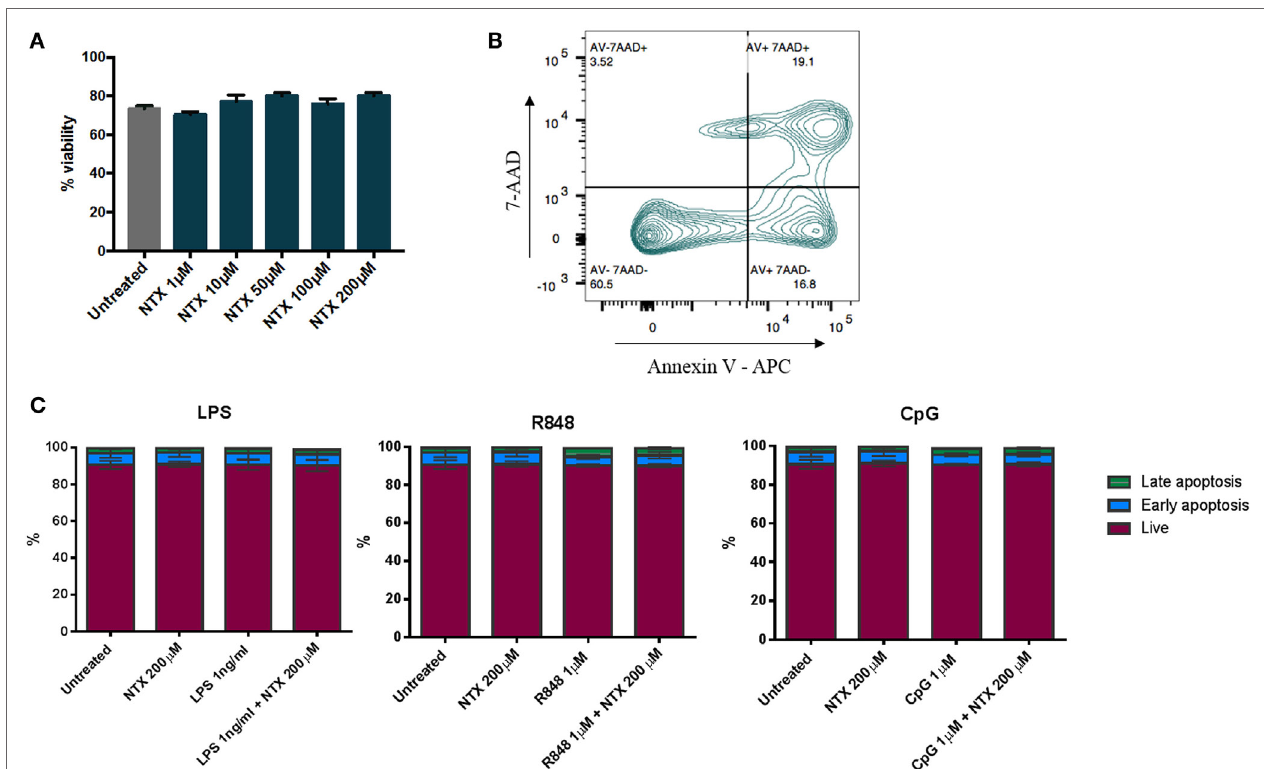
FigUre 4 | Toll-like receptor ligand (TLR-L) and naltrexone does not affect the viability of peripheral blood mononuclear cells (PBMC). (a) 1 × 10 6 PBMC were incubated with 1–200µM naltrexone for 24 h before percentage viability was assessed using trypan blue exclusion. (B,c) 1 × 10 6 PBMC were incubated with 1 ng/ ml LPS (TLR4-L), 1µM R848 (TLR7/8-L), 1µM CpG (TLR9-L), and 200µM naltrexone for 24 h. PBMC were incubated with annexin V and 7AAD before being analyzed by flow cytometry. Figure 4B shows the gating strategy, and Figure 4c shows results from 4 donors. AV − 7AAD − are viable cells, AV + 7AAD − are in early apoptosis, and AV + 7AAD + are in late